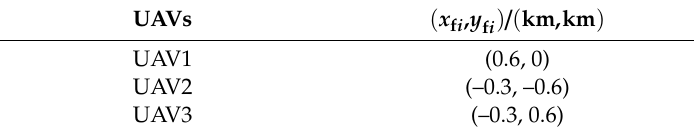
Table 3. Lengths of three paths and their minimum separation distances.